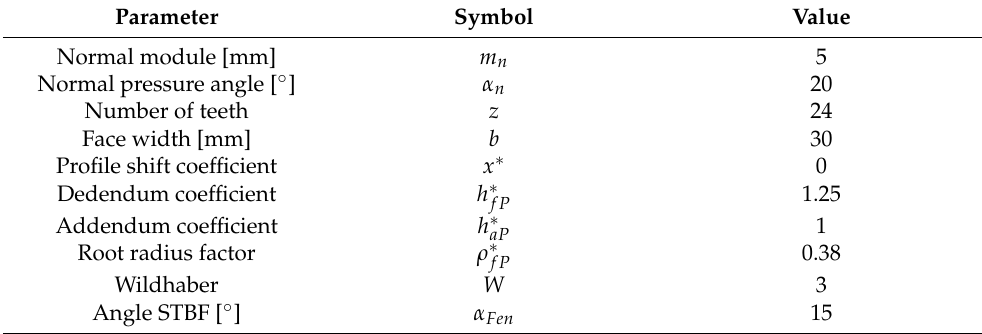
Table 1. Gear geometry.